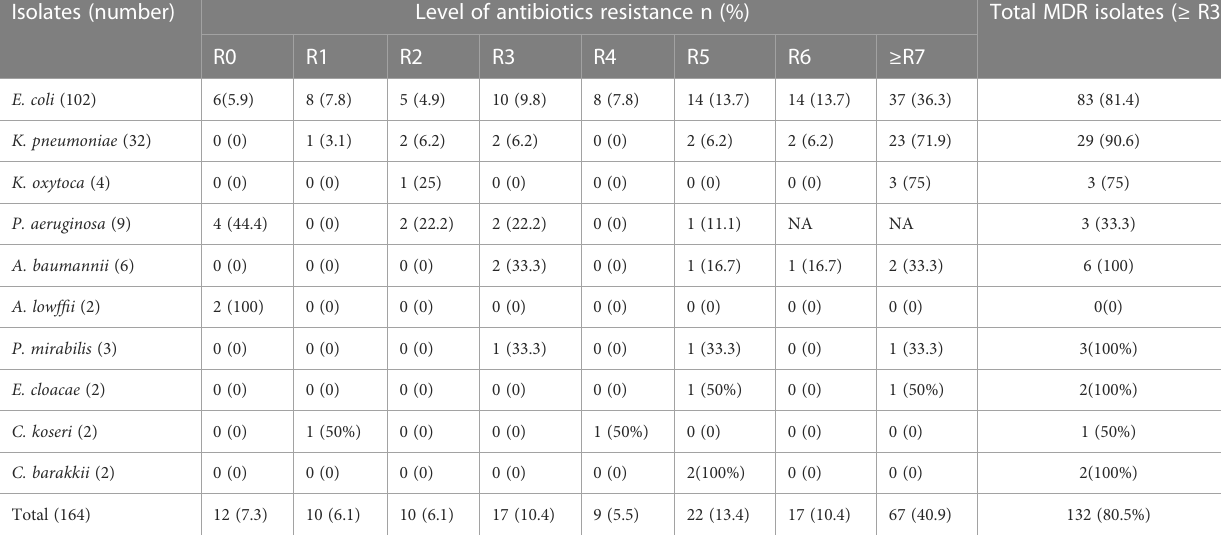
TABLE 4 Multidrug resistance level of bacteria isolated from different clinical specimen. Isolates